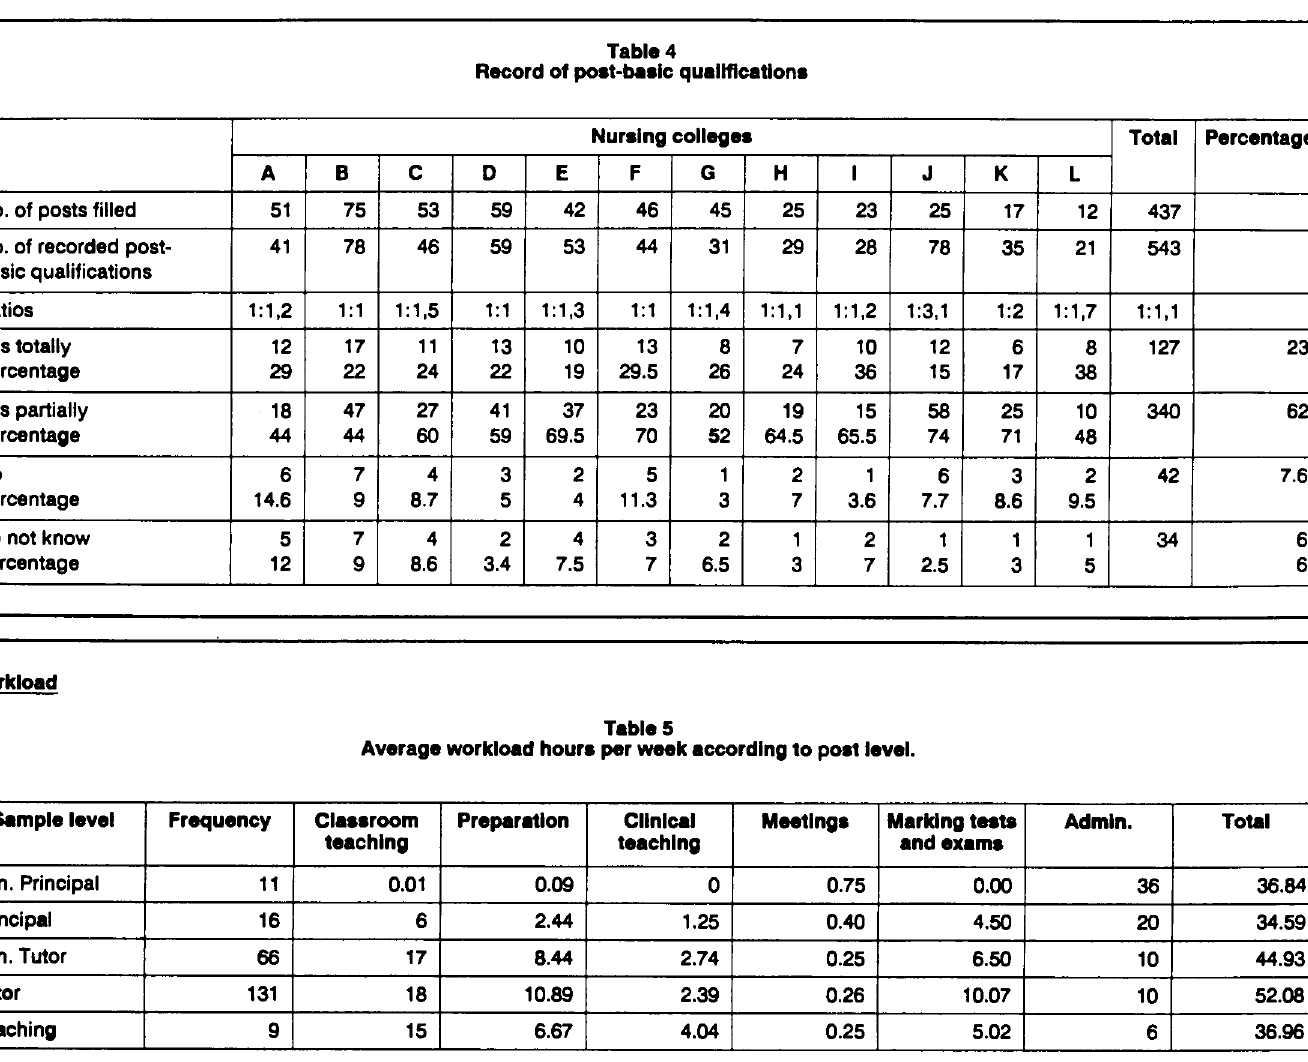
Table 5 Average workload hours per week according to post